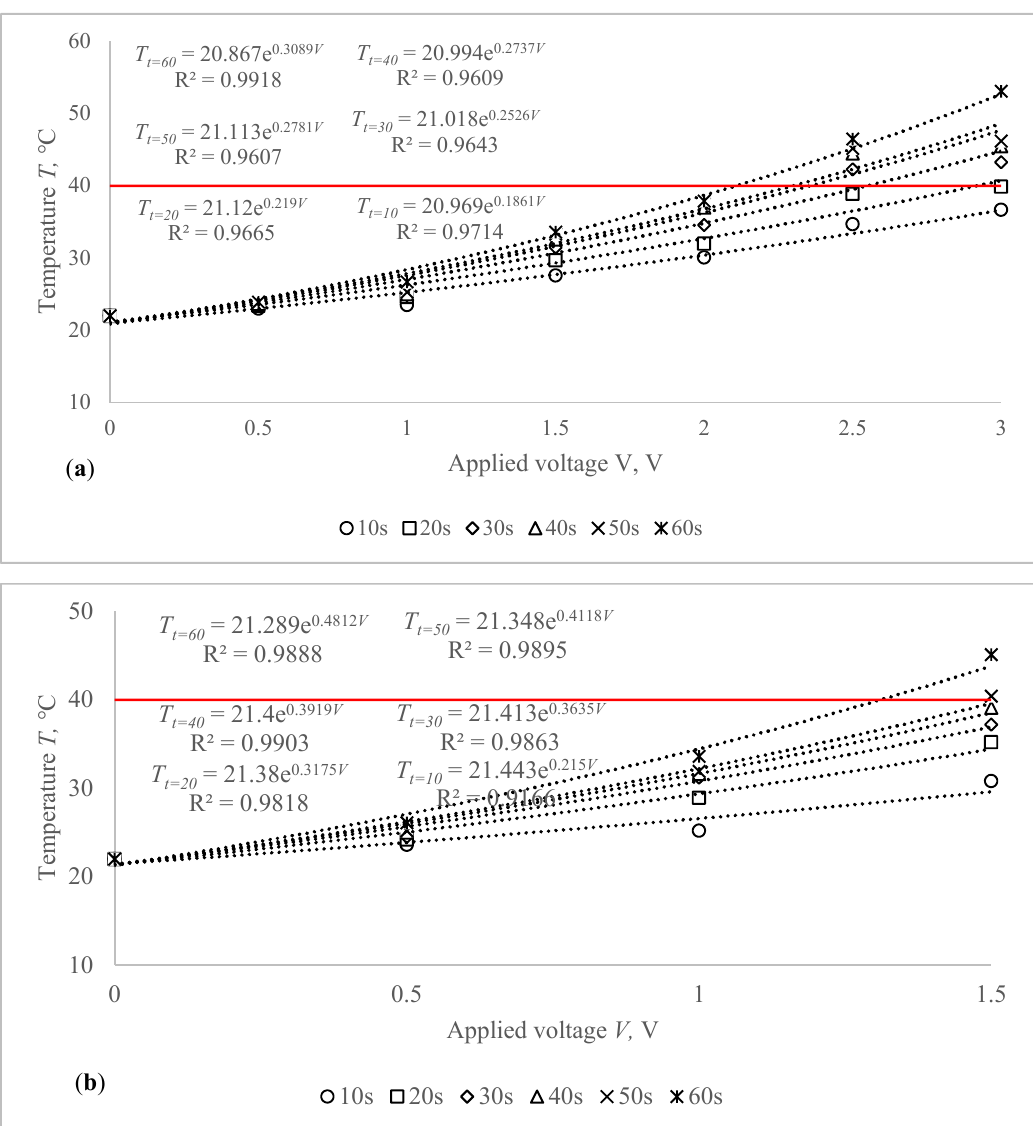
Figure 6. Voltage–temperature characteristics of non-stretched composite fabrics during 60 s at 10 s intervals for different applied voltage: ( a ) CF_LY1 and ( b ) CF_HY1 structured electro-conductive fabric (Red line indicates the target temperature). Table 4. Voltage–temperature characteristics at different stretching levels of developed electro-con- ductive composite fabrics for 60 s.